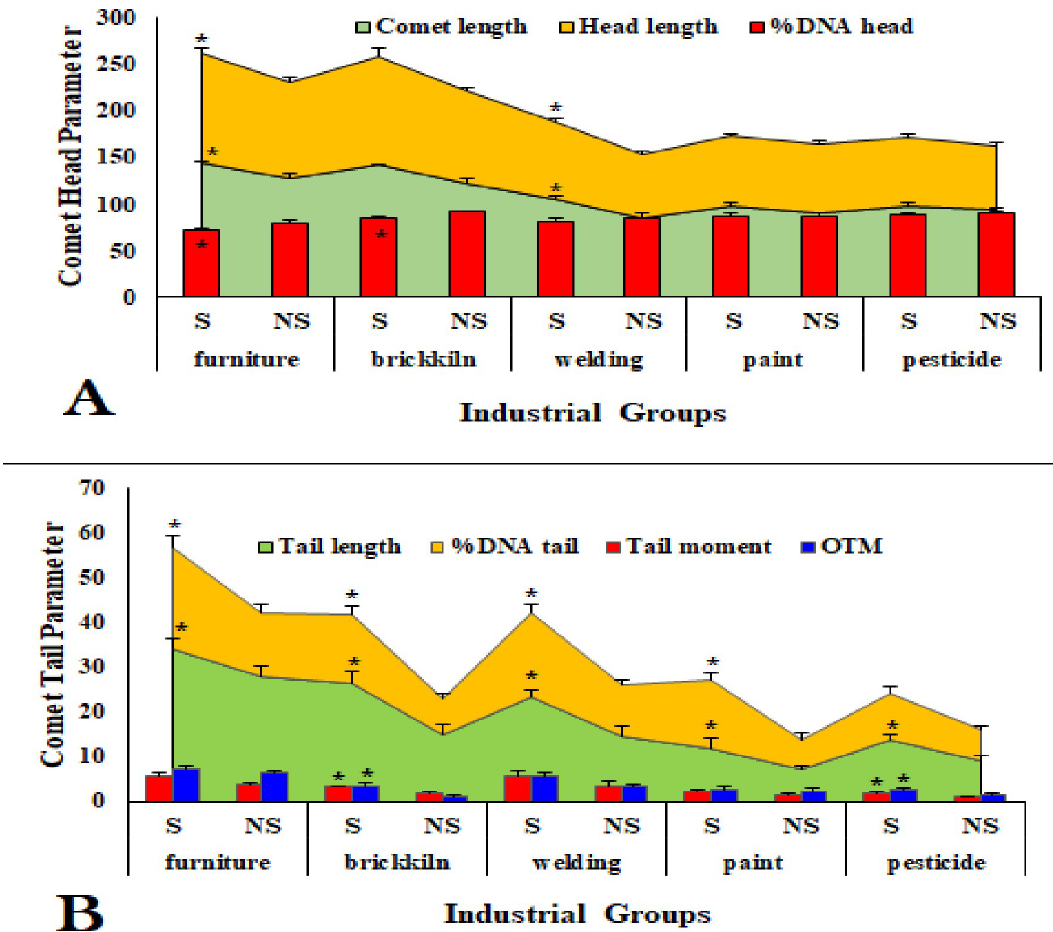
Fig 3. Different comet parameters associated with comet head and tail measured by comet assay in smokers (S) and non- smokers (NS) of exposed workers from different industries. � P < 0.05, �� P < 0.01, ��� P < 0.001.